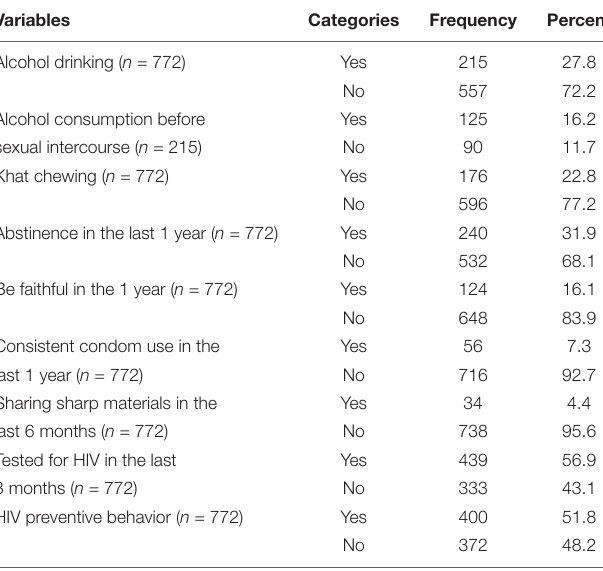
TABLE 2 | Behavioral profiles and HIV preventive behavior of the respondents at Majang Zone in Southwest Ethiopia, 2019.